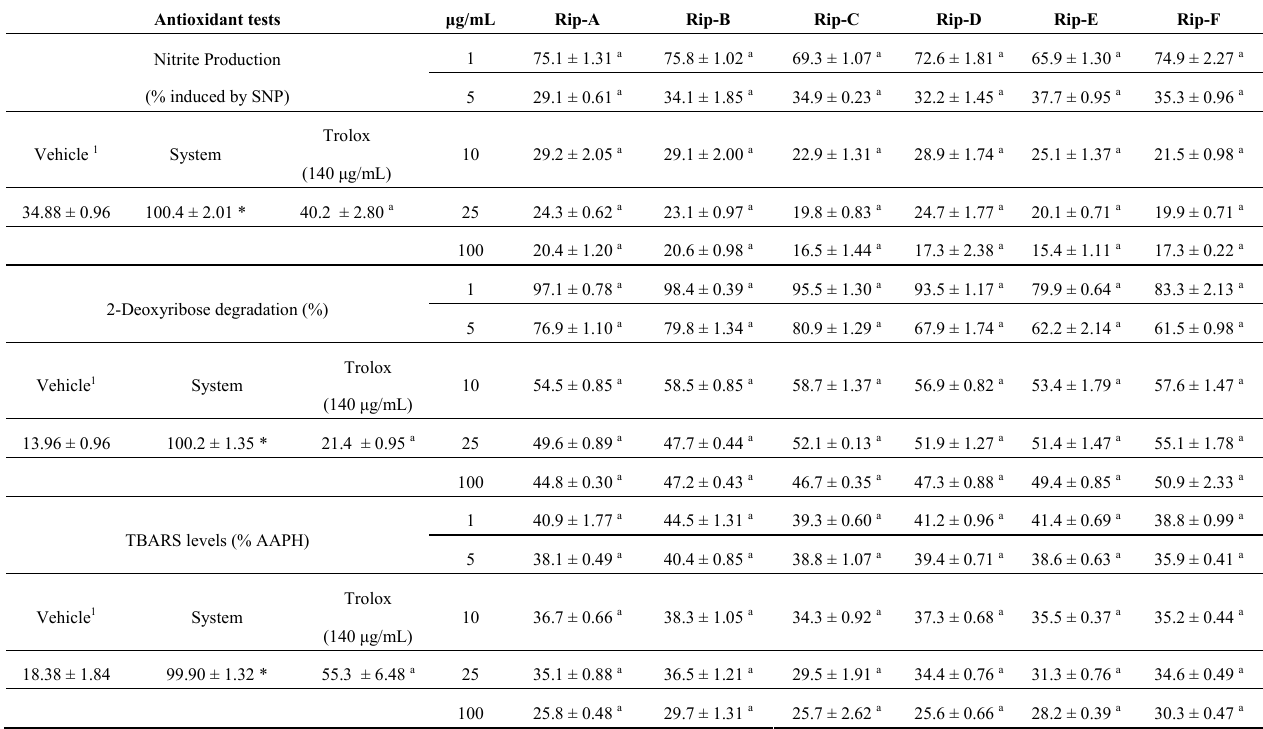
Table 3. Antioxidant potential in vitro of riparins A-F in TBARS production, hydroxyl radical content and nitric oxide formation.